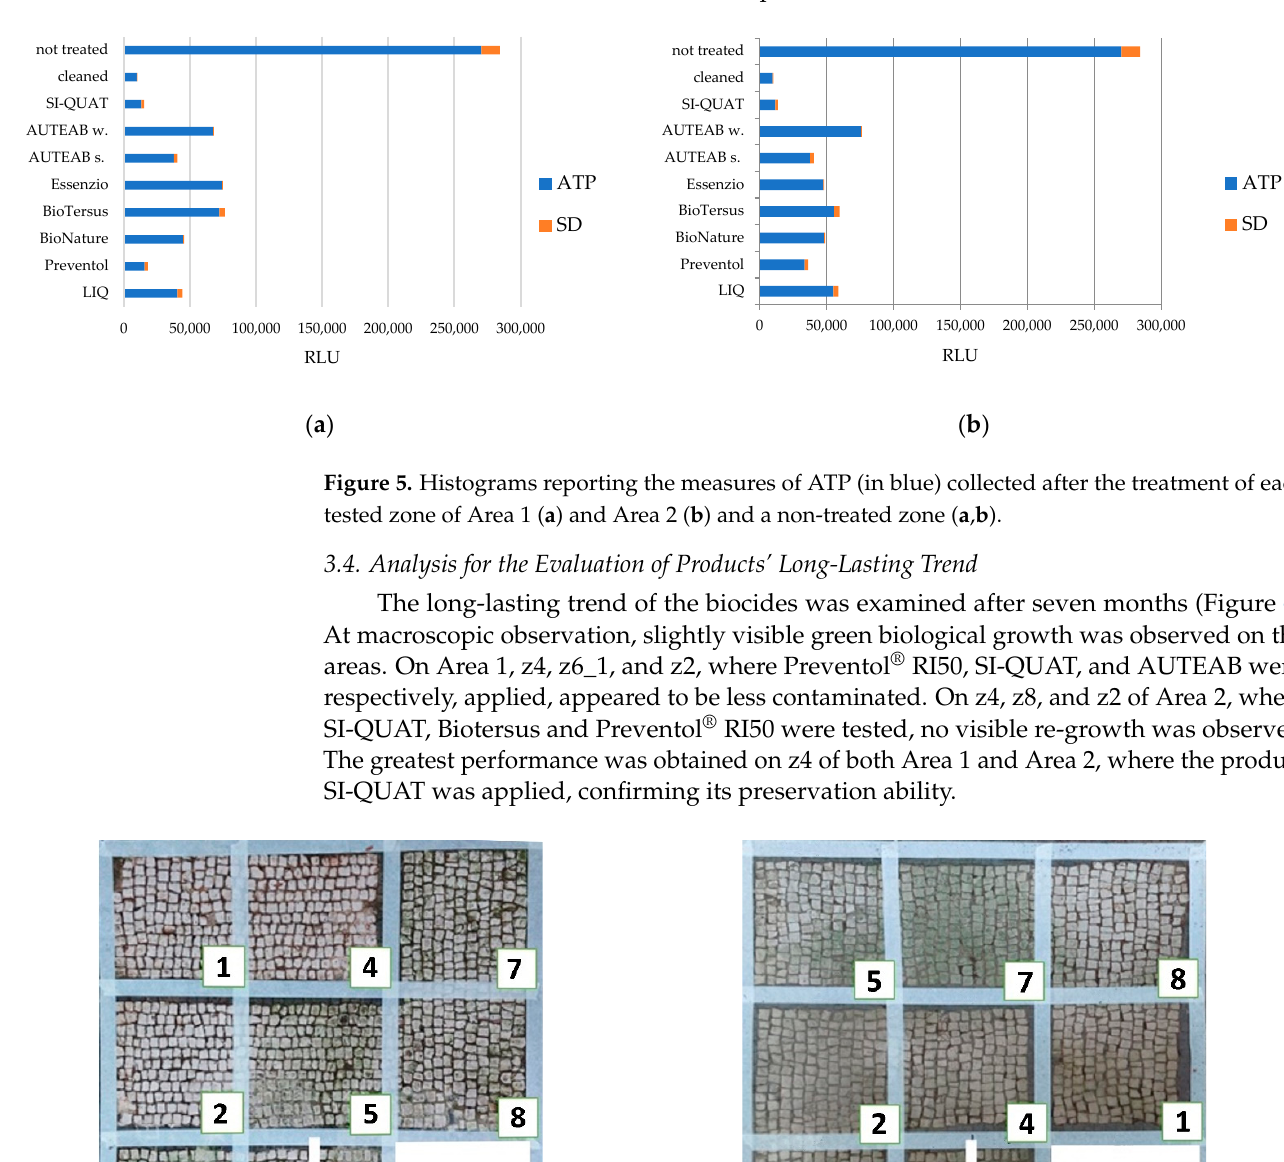
AUTEAB washed, BioNature, and LIQ were, respectively, applied. The area treated with SI-QUAT showed a similar trend if compared with z1.